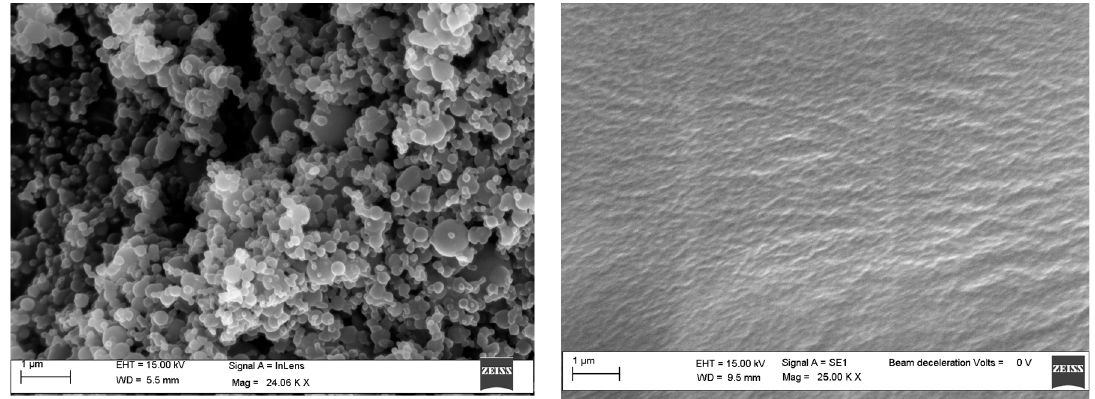
Figure 1. SEM images of polystyrene before ( left ) and after ( right ) drying in a stove.